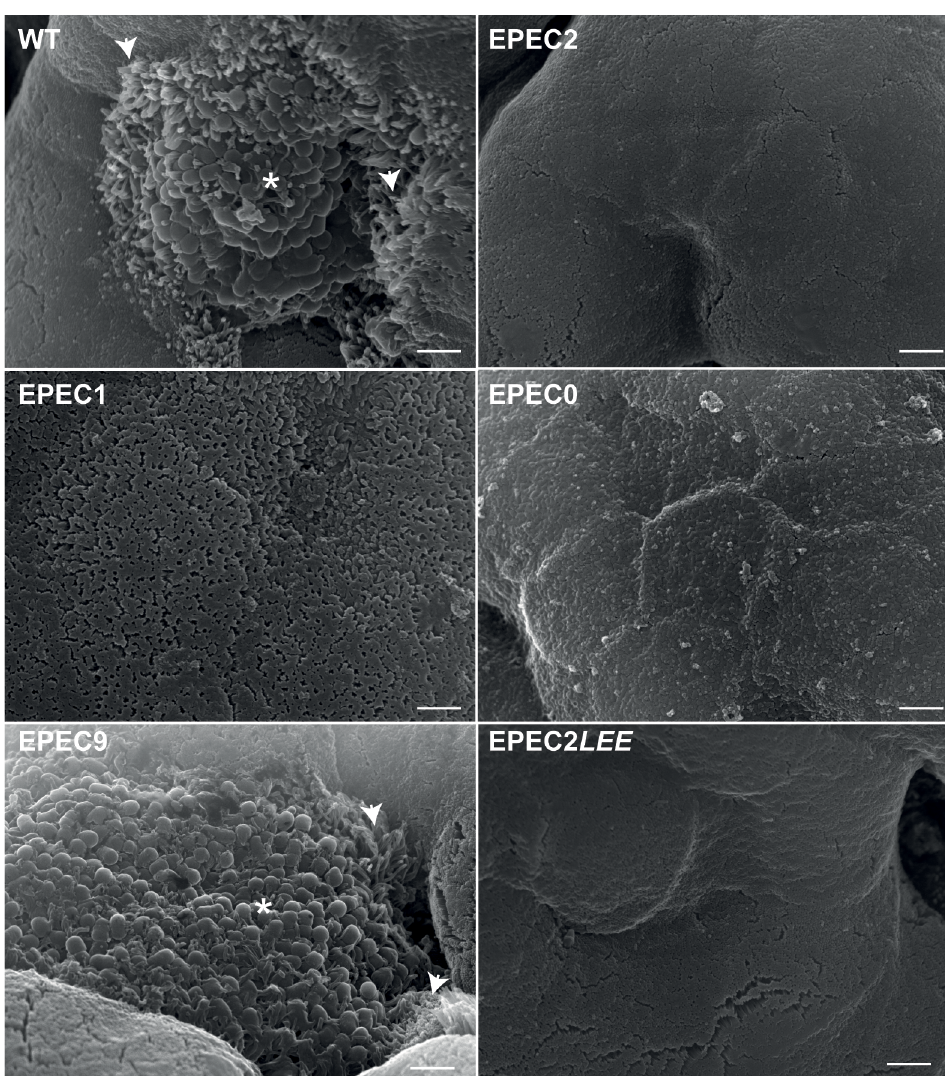
Fig 5. A/E lesion formation in human intestinal biopsies infected with EPEC effector mutant strains. Representative scanningelectron micrographs of humanduodenalbiopsiesinfected with the indicatedEPEC strains. WT EPEC and EPEC9 strains inducethe characteristic A/E lesionsin the intestinalmucosal surface, forming bacterialmicrocolonies (asterisk) and elongation of microvilli at the peripheryof the microcolony (arrowheads). Biopsiesinfected with EPEC2, EPEC1, EPEC0 show a smooth epithelialsurface without any adherentbacteria. Most biopsiesinfected by EPEC2 LEE (10/11) also showed an intact mucosal surface without bacteria. Scale bar 2 μ